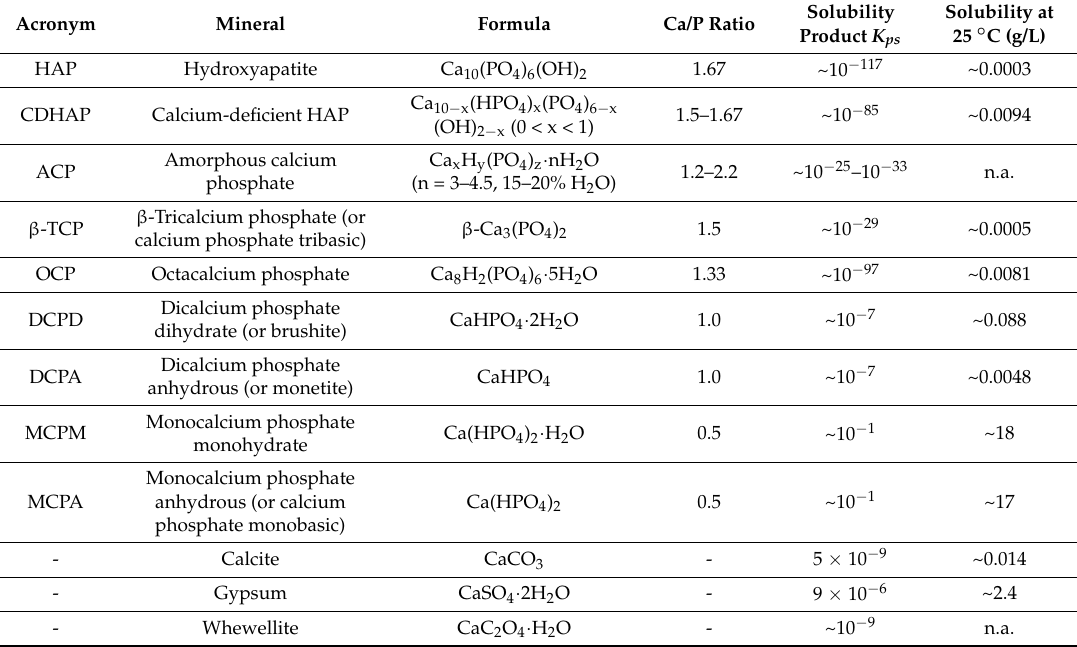
Table 2. Nomenclature and solubility of CaP phases [22], compared to calcite [27,36], gypsum [8,36] and whewellite [28] (n.a. = not